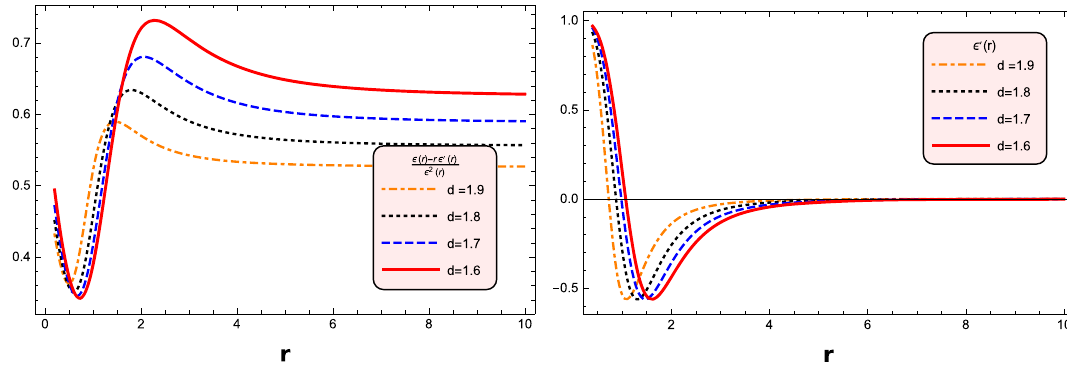
Fig. 2 Condition (cid:3)( r ) − r (cid:3)